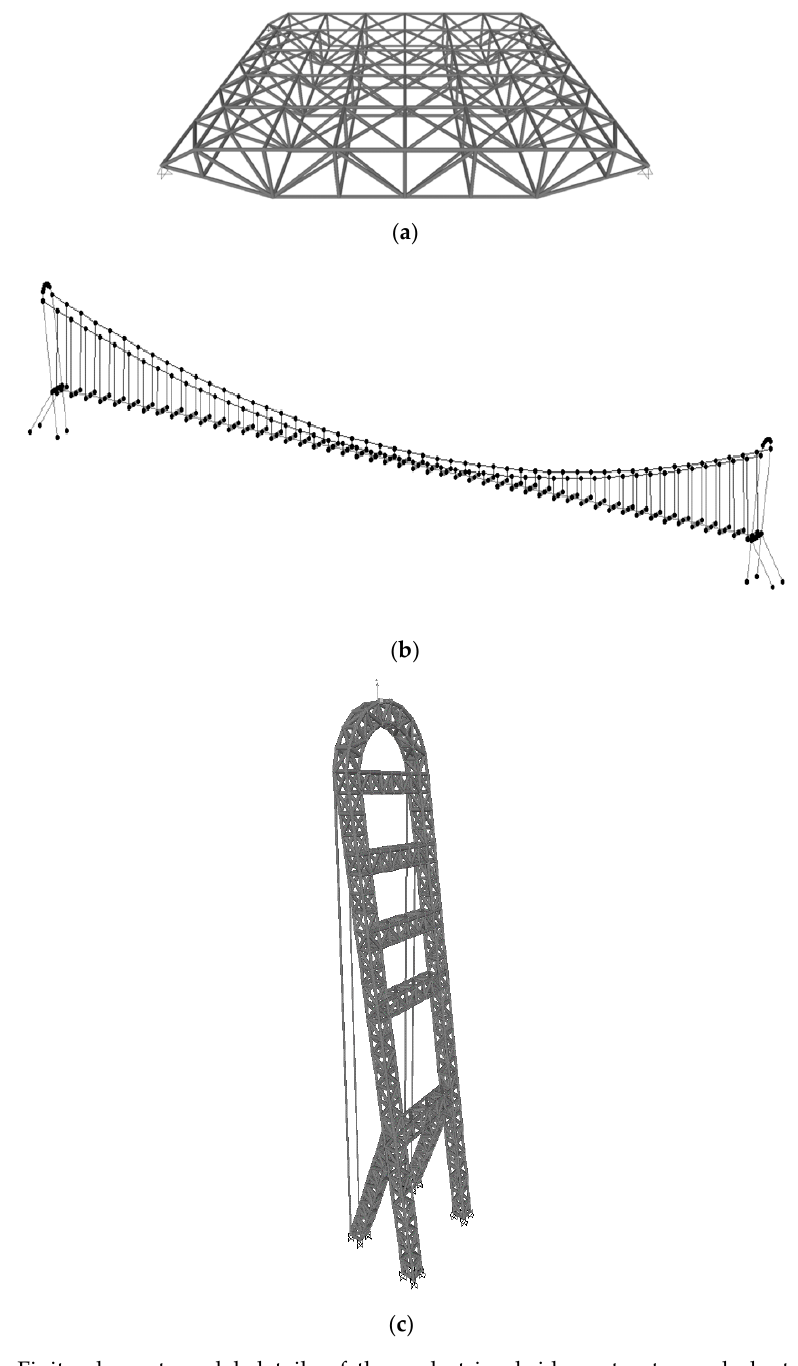
Figure 6. Finite element model details of the pedestrian bridges structure: deck structure ( a ), tower ( b ) and bridge ( c ) [20] Modal analysis was carried out to estimate natural angular frequencies. The angular frequencies of the first symmetric and asymmetric vertical and torsional modes are listed in Table 4 for load (Tables 2 and 3) and geometrical (Table 1) configurations and for each material (i.e., steel and wood and hemp). Table 4. First vertical and torsional natural frequencies [14].